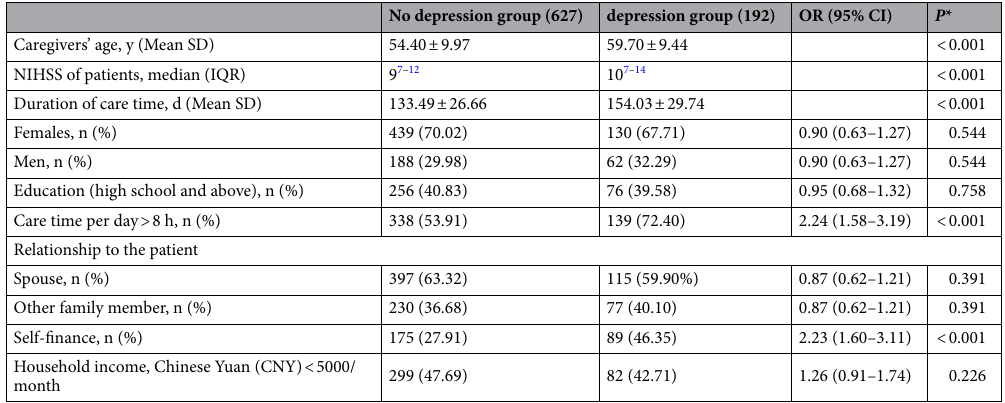
Table 3. Comparison of baseline characteristics between caregivers with no depression and depression